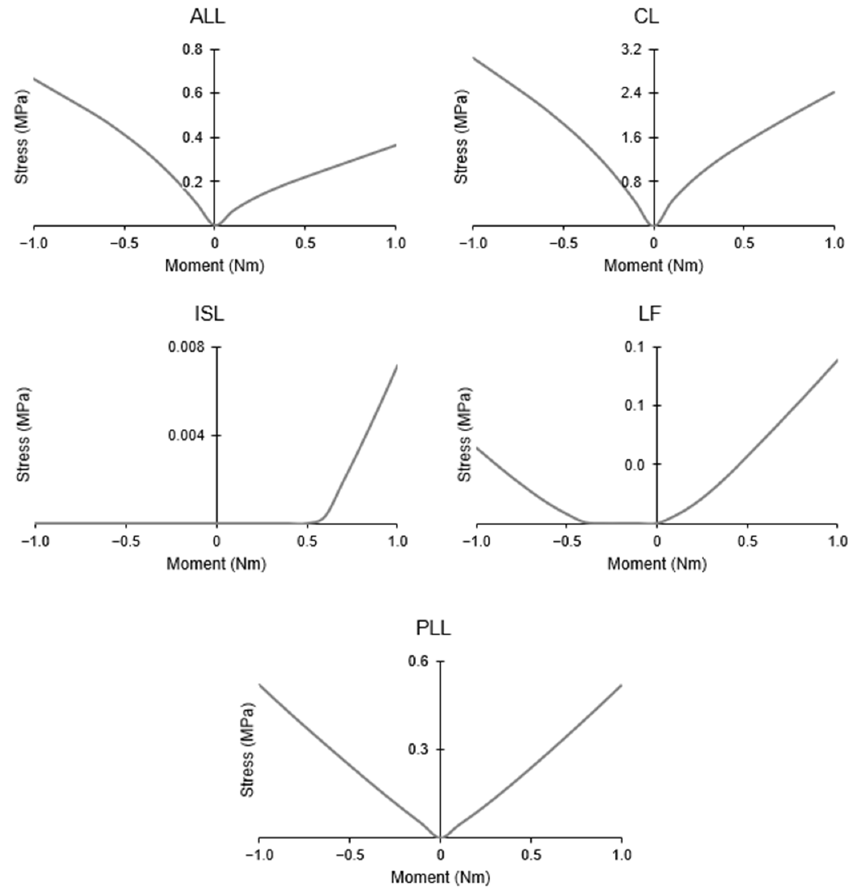
Figure 9. Maximum stress registered by each ligament during lateral bending.